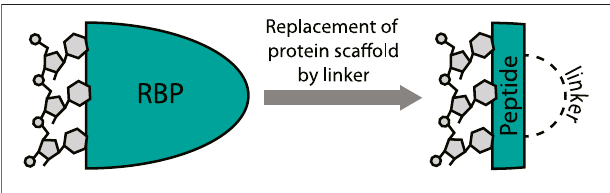
FIGURE 3 | Excising a peptide from an RNA-binding protein provides a mimic that can target the RNA. A covalent linker replaces the protein